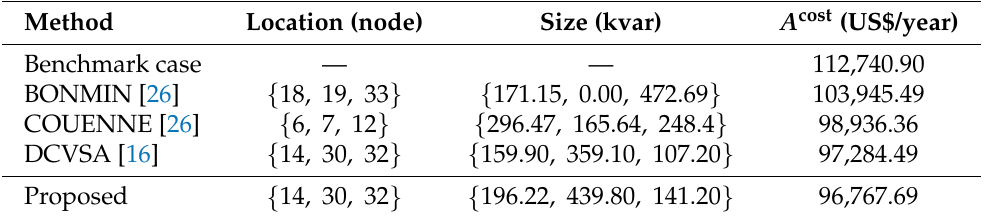
Table 5. Numerical results in the IEEE 33-bus system for the proposed and comparative